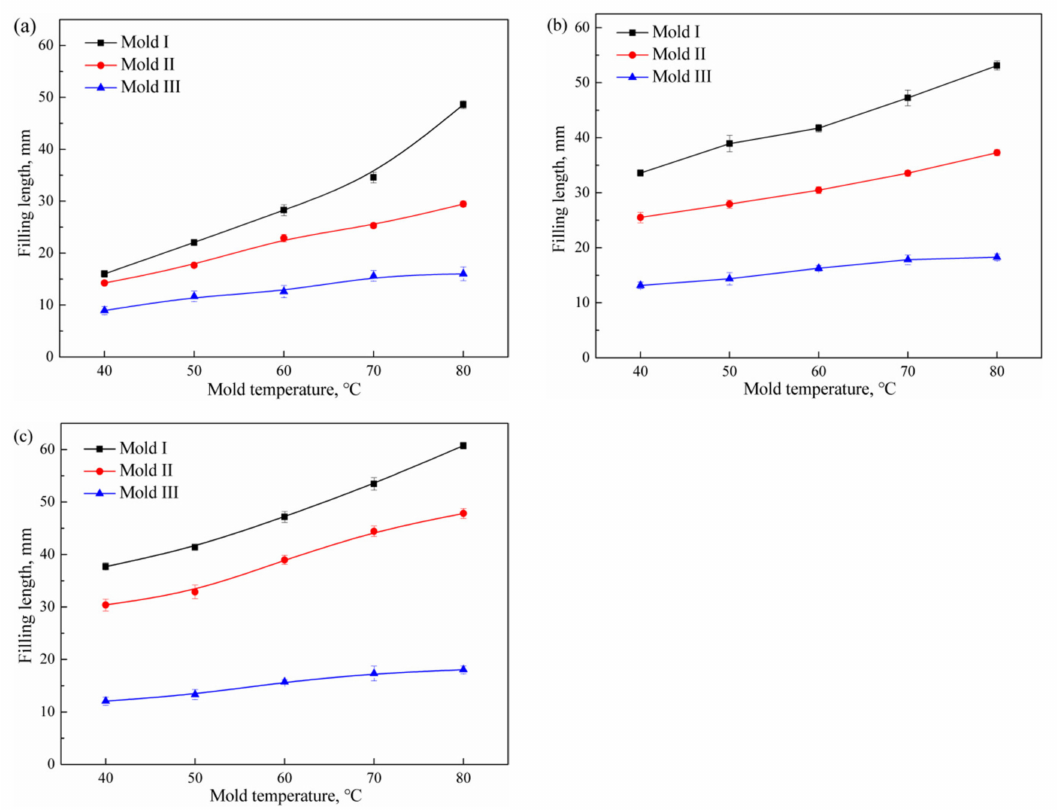
Figure 7. Filling length of polymer melt in different mold ( a ) PMMA; ( b ) PP; ( c )